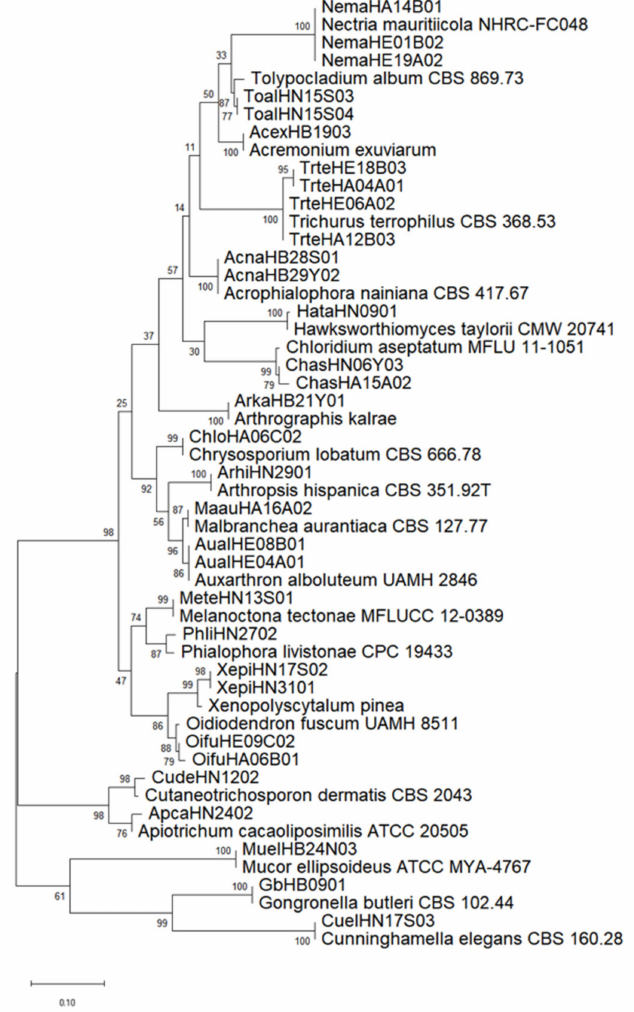
Figure 5. Phylogenetic tree of other